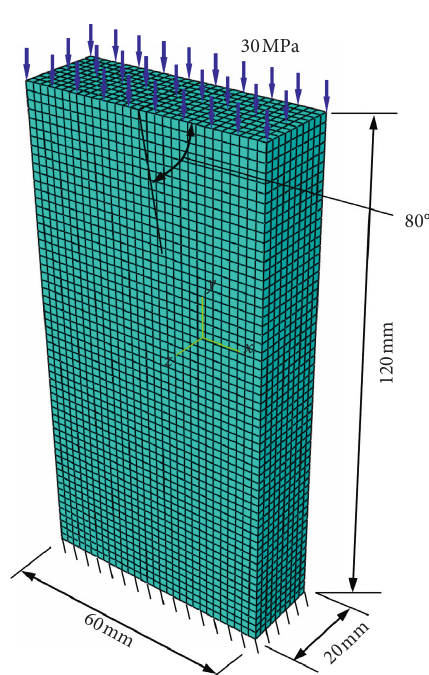
Figure 4: Numerical model with closed crack.